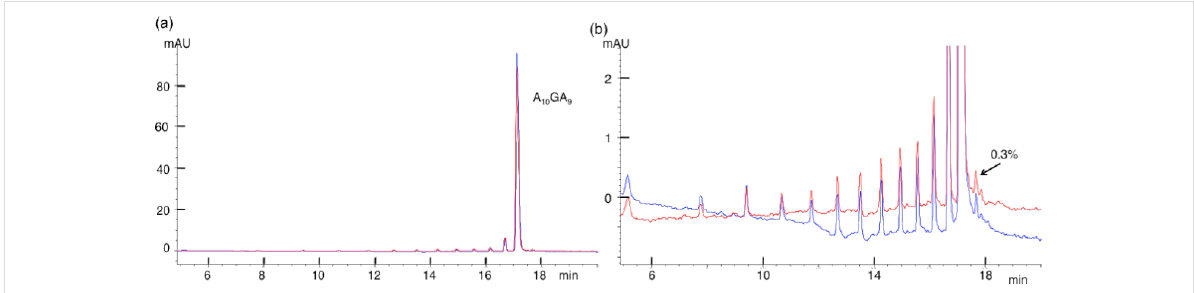
Figure 5: Overlapping HPLC profiles of A 10 GA 9 before (red) and after (blue) osmylation to show no detectable reactivity of A and G with OsBp. (b) Oligo, about 85% pure, in full scale, and (b) the magnification shows the presence of small impurities, the shorter oligos with n − 1. The chromatog- raphy resolves oligos based on length with n − 1 eluting ahead of n . Please note that all shown oligos of decreasing length from n − 1 to n − 10 must contain one G. The impurity at 0.3% of the main peak is marked to visualize the detectability level of this specific experiment.